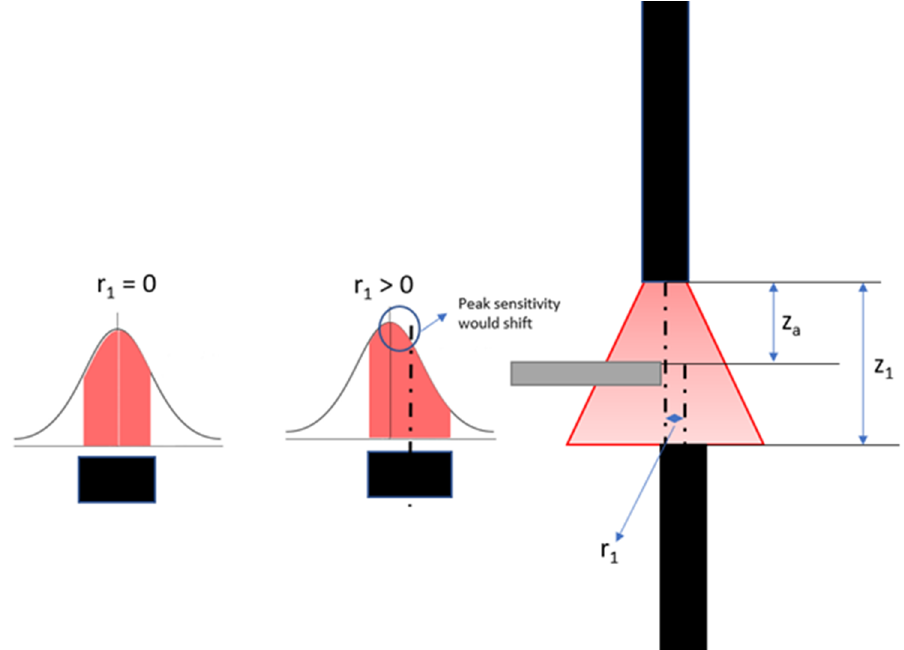
Figure 12. When a radial offset between both optic fibers is introduced, the location of maximum sensitivity shifts.